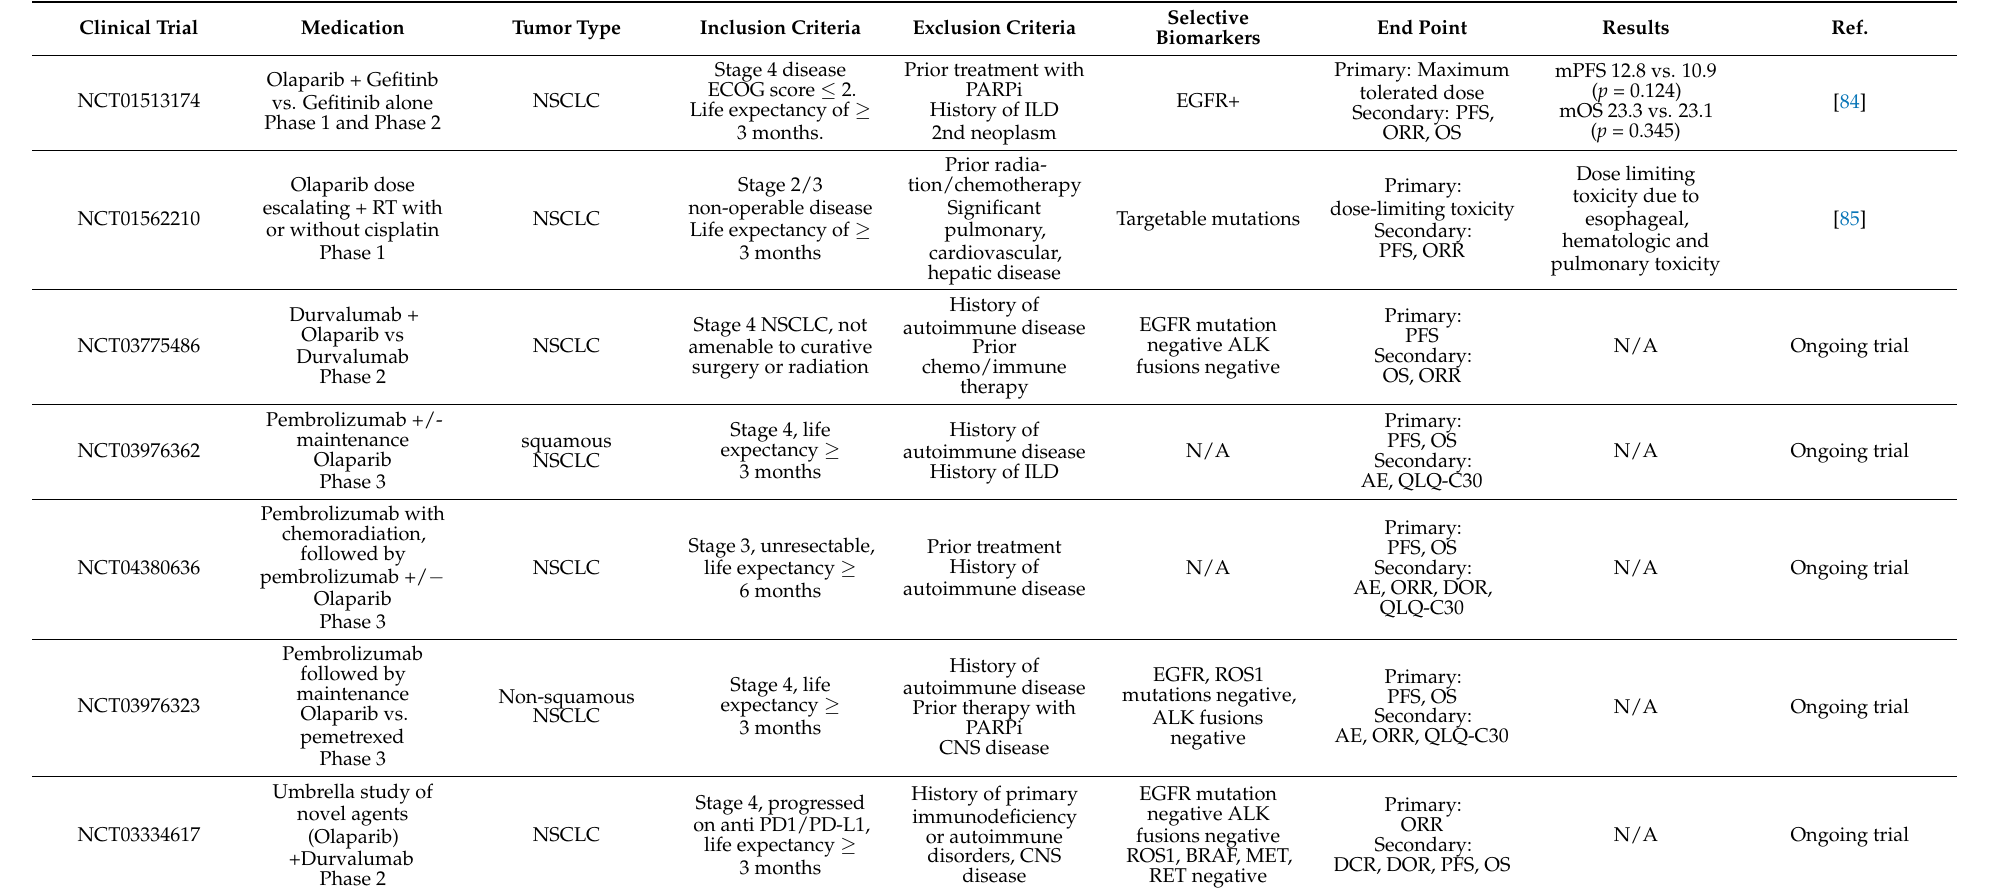
Table 1. A summary of selected clinical trials with PARPi in